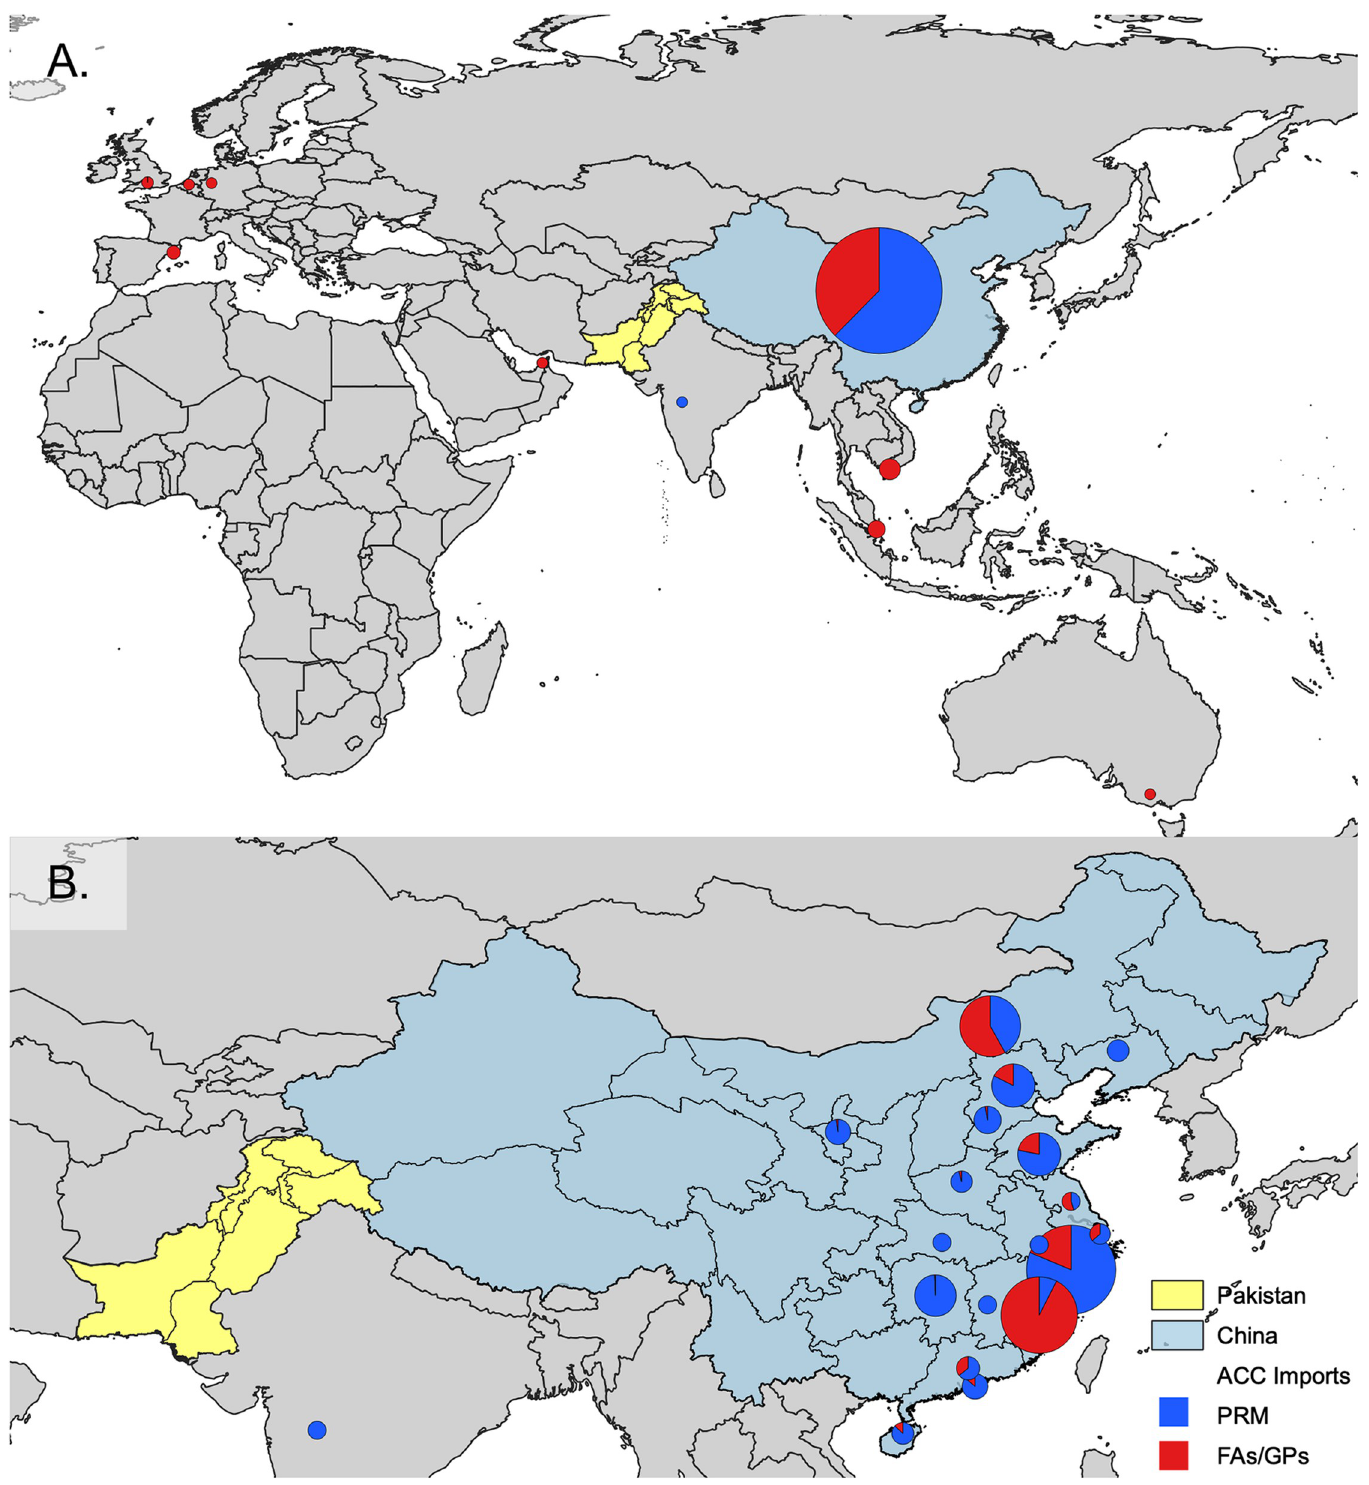
Fig 1. Total volumes and ratios of pharmaceutical raw materials and feed additives/growth promoters antimicrobial chemical compounds for the years 2017–19 imported from: A. different countries and B. China and its different provinces.